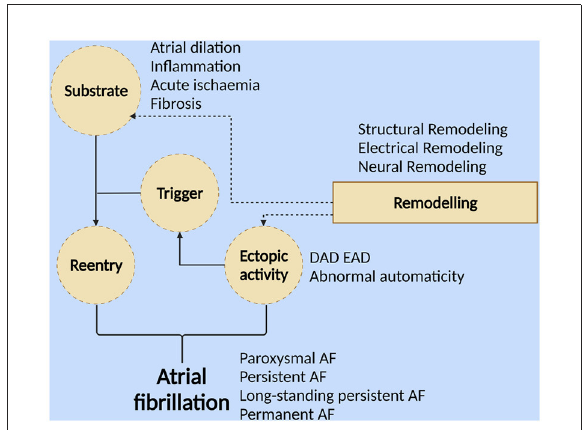
FIGURE1 Different forms of atrial fibrillation result from ectopic activity and/or reentry. The formation of reentrants requires triggering activity and a matrix that is susceptible to reentrant formation. “Triggering” is a series of ectopic activities with abnormal autonomy (including early postdepolarization and delayed postdepolarization). Atrial dilation, inflammation, myocardial ischemia, fibrosis, etc., can form substrates that facilitate the formation of reentry. “Substrate” refers to persistent changes in structure, electrophysiological parameters, and innervation. Atrial remodeling, including electrical, structural, and neural remodeling, promotes the formation of this AF-prone substrate and the development of ectopic activity (Created with